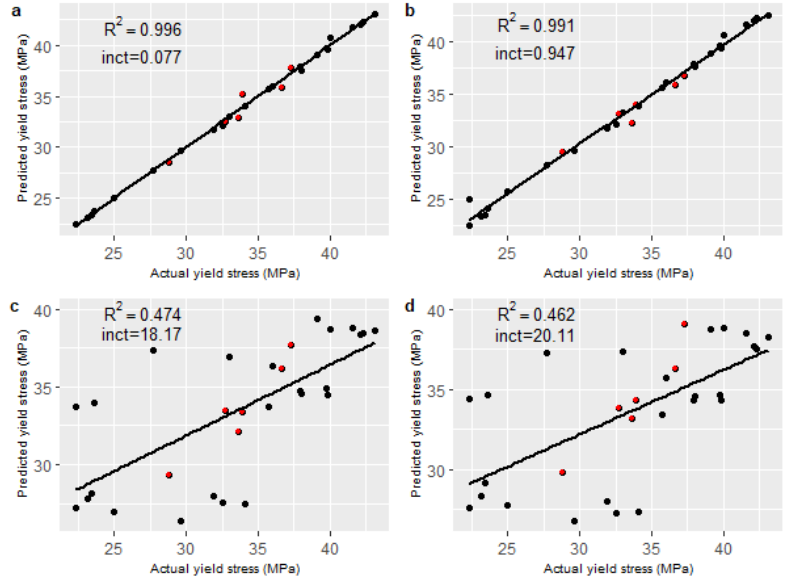
Figure 3. Linearity plots with R 2 and intercept values for all unseen data. ( a ) PCA–RF; ( b ) PCA–SVR; ( c ) PLS (n = 4); ( d ) PCR (n = 5). The black points relate to the internal validation set and the red points relate to the external test